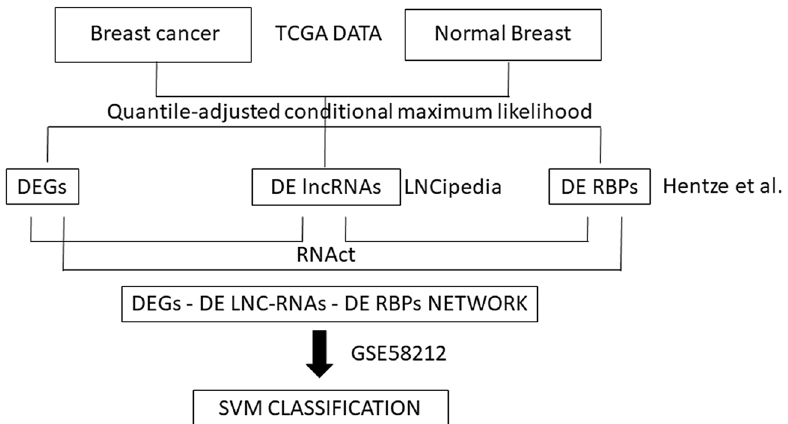
Figure 1. Workflow of the computational approach. The computational method was applied considering the comparison of each breast cancer (BC) subtype vs normal breast tissue. Differential expressional analysis with quantile-adjusted conditional maximum likelihood was performed on The Cancer Genome Atlas (TCGA) data between each breast cancer subtype and normal breast tissue. The analysis identified differentially expressed genes (DEGs), differentially long non-coding RNAs (DE lncRNAs) and differentially RNA-binding proteins (DE RBPs). lncRNAs and RBPs were defined by LNCipedia and by study of Hentze et al. Furthermore, we evaluated the interactions among DEGs, DE lncRNAs and DE RBPs using RNAct tool. The expression levels of interacting DEGs, DE lncRNAs and DE RBPs specific for each BC subtype were considered as biomarkers to classify BC subtypes with Support Vector Machine (SVM) classification, using an independent dataset of Gene Expression Omnibus (GEO),